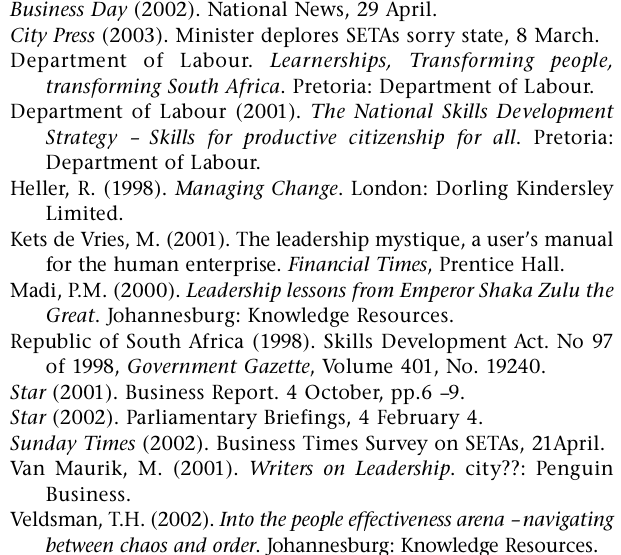
Figure 16 (cid:1) allow leaders within specific SETAs to develop at their own